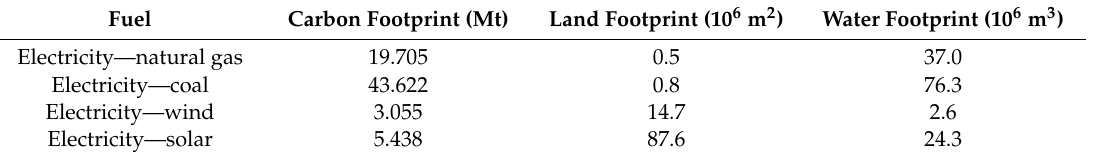
Table A7. Carbon, land and water footprints for scenario 3, the electricity